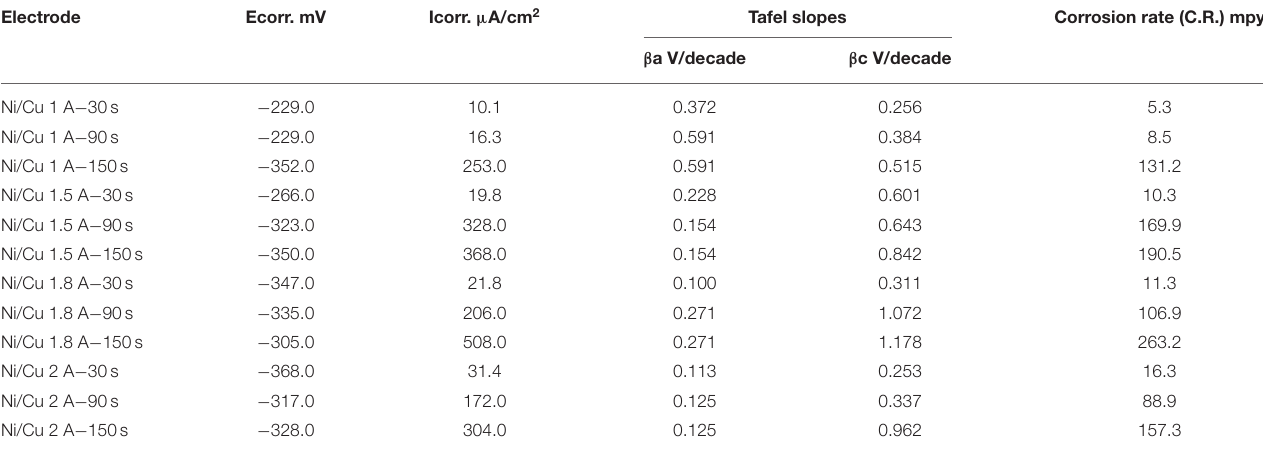
TABLE 4 | Polarization data for the corrosion of electrodeposited Ni–Cu foam at different current densities (A/cm 2 ) and different times (30, 90, 150s) using 1M KOH at 25 ◦ C.